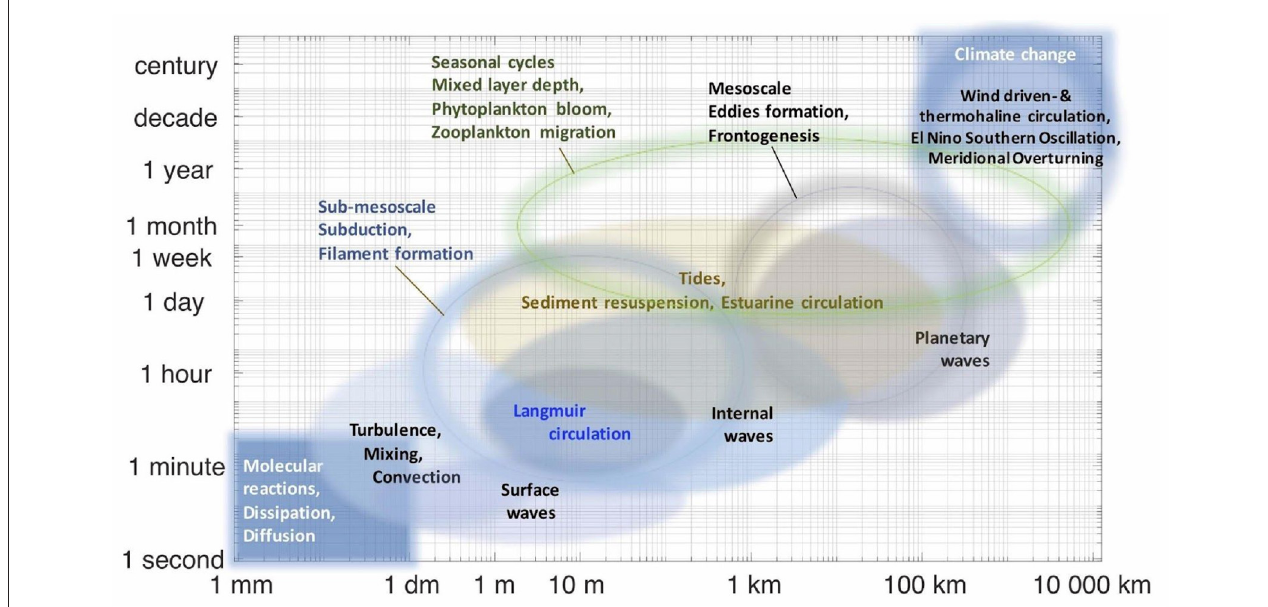
FIGURE 2 | Processes and features that generate variability in the ocean on various temporal and spatial scales. The sketch has been refined and redrawn, inspired by an illustration by Dickey